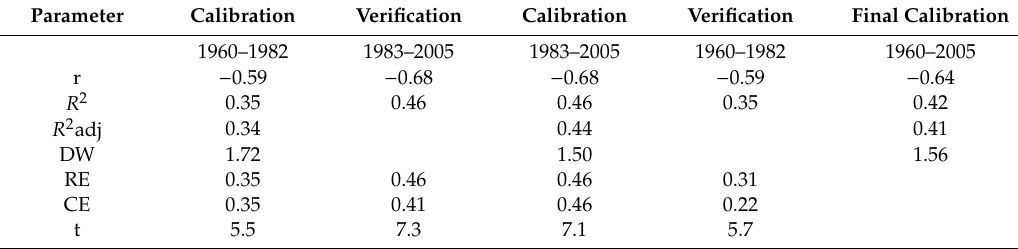
Table 3. Statistics of calibration and verification test results for the common